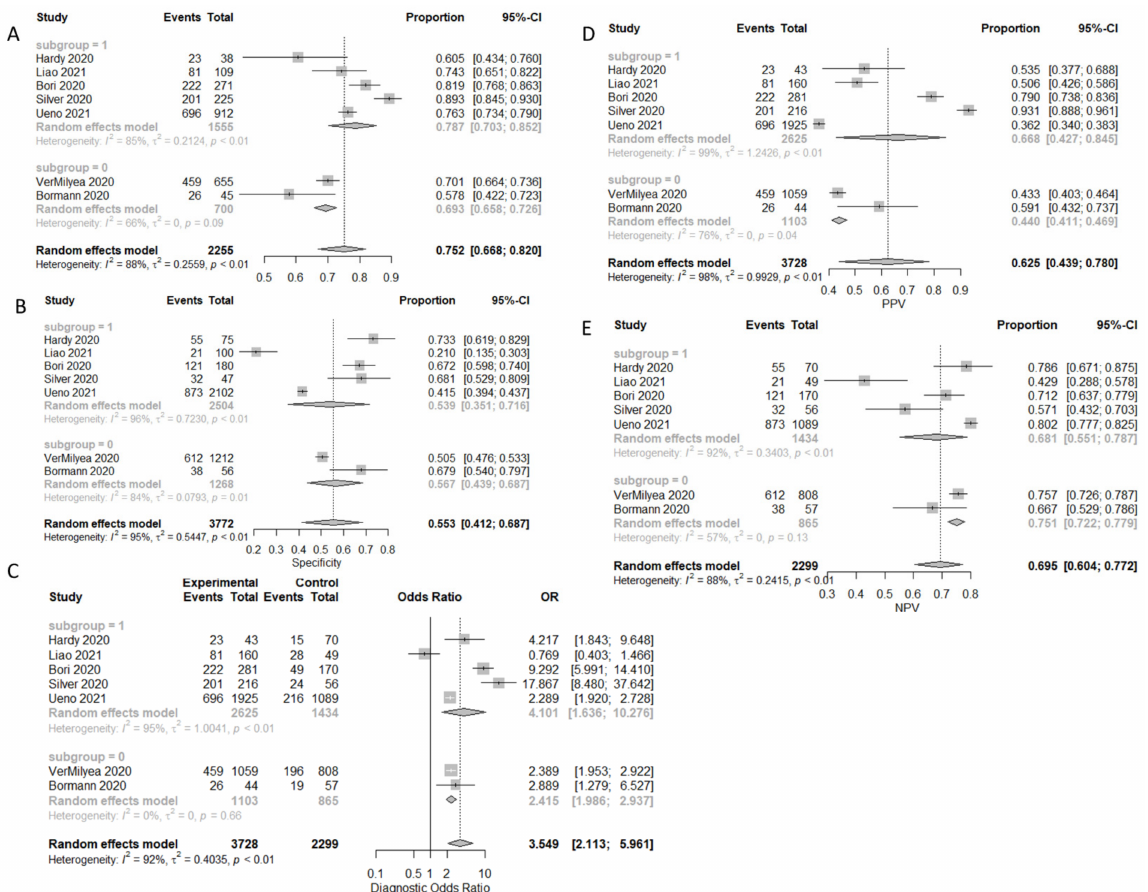
Figure 6. Forest plots representing: ( A ) sensitivity; ( B ) specificity; ( C ) DOR; ( D ) PPV; ( E ) NPV of the clinical pregnancy with fetal heart beat prediction outcome. Subgroup “0” represents static images as type of input, and subgroup “1” represents